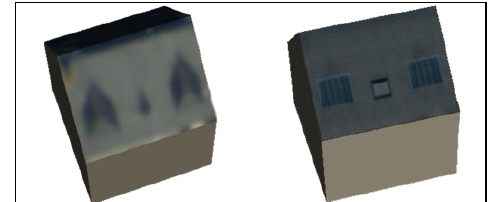
Figure 5. Error in object interpretation: the two glass walls are simple 2D